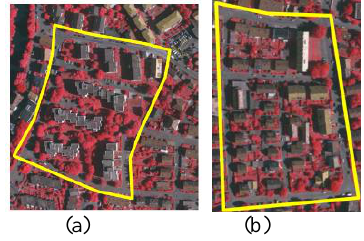
Figure 5: Test data set, (a) Area 1, (b) Area 2